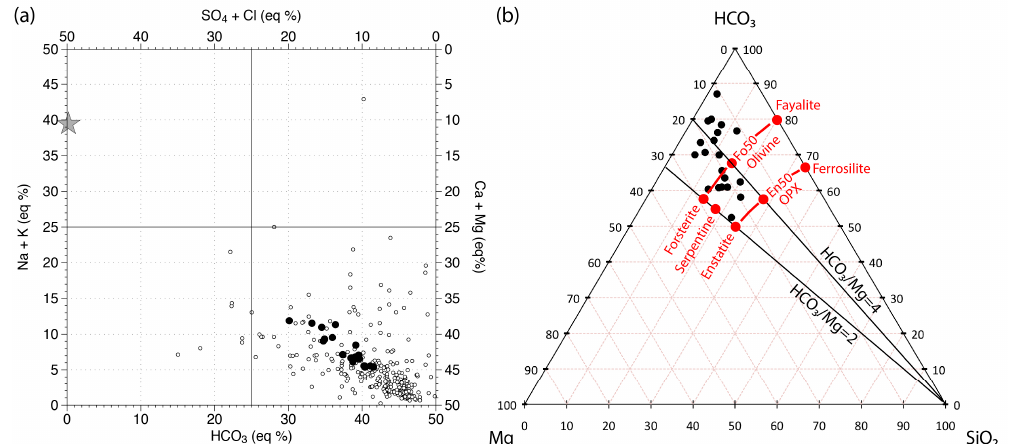
Figure 4. ( a ) Langelier–Ludwig diagram showing the sampled stream waters (black dots) and 375 groundwaters of the Voltri Massif (white dots [70]). For reference, mean seawater composition is plotted as a grey star. ( b ) Trilinear Mg-SiO 2 -HCO 3 plot based on molal composition: the composition of stream waters (black dots) are compared to composition of theoretical solutions deriving from dissolution of some relevant mafic minerals (red dots). The red lines represent the olivine and orthopyroxene series. The HCO 3 /Mg = 2 line represents the solutions resulting from dissolution of pure Mg silicates while the HCO 3 /Mg = 4 line represents the solutions deriving from dissolution of silicates where Mg is 50% of the divalent cations.